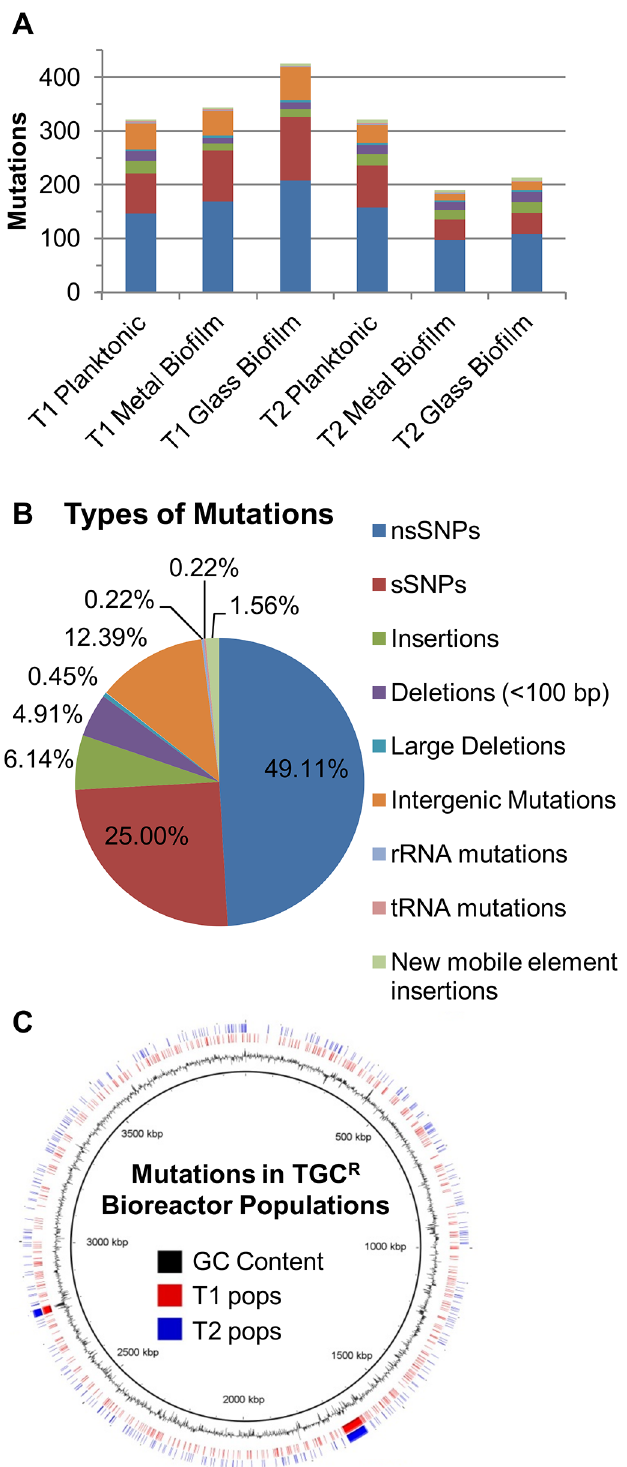
Fig 2. Metagenomic analysis of endpoint populations illustrated the diversity of mutations in the adapting populations. Mutations with a frequency (cid:1) 5% isolated from different locations and trials of the bioreactor are shown: (A) the number of mutations for each spatial sample; and (B) total frequency and types of mutations across all populations. (C) Lines indicate locations of the mutations in the AB210M genome (Trial 1, red; Trial 2, blue). doi:10.1371/journal.pone.0140489.g002 PLOS ONE | DOI:10.1371/journal.pone.0140489 October 21,